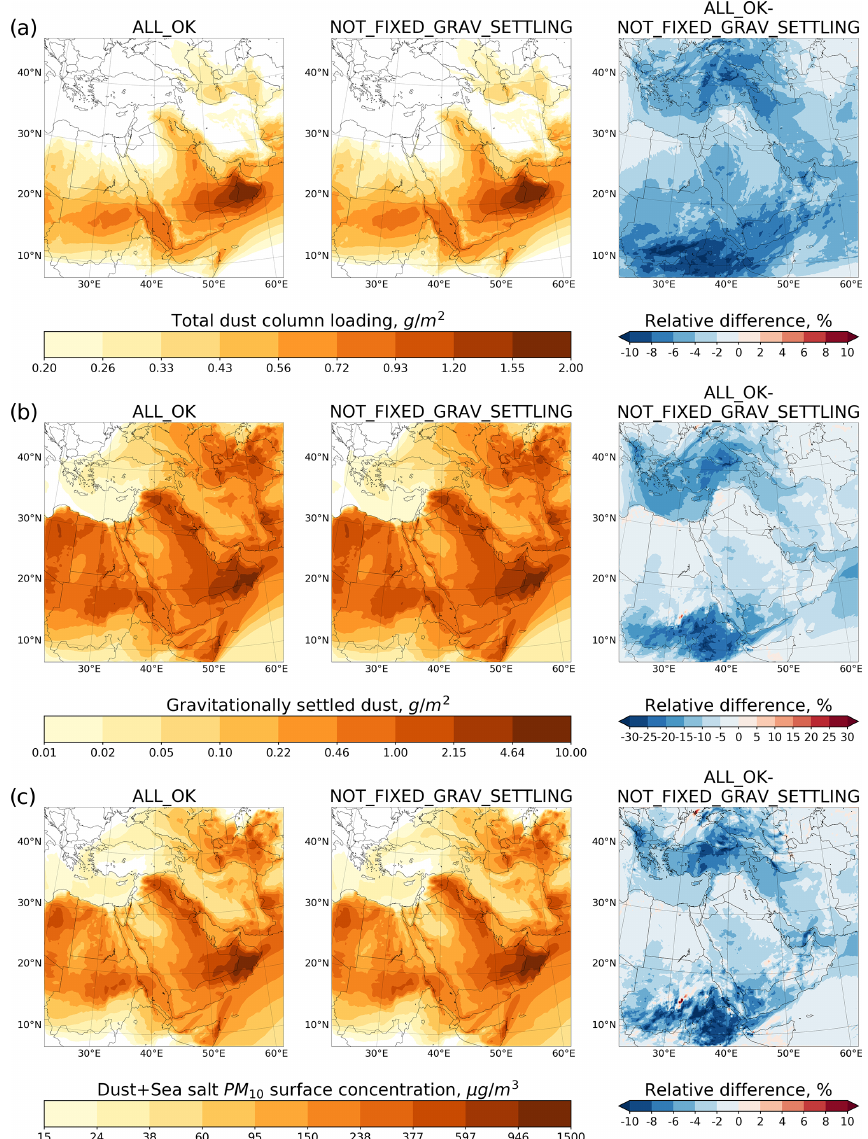
Figure 6. Comparison of ALL_OK and NOT_FIXED_GRAV_SETTLING runs. (a) Averaged total dust column loadings (gm − 2 ) and relative difference (%). (b) Gravitationally settled dust (gm − 2 ) and relative difference (%). (c) Averaged dust and sea salt PM 10 surface concentra- tions (µgm − 3 ) and relative difference